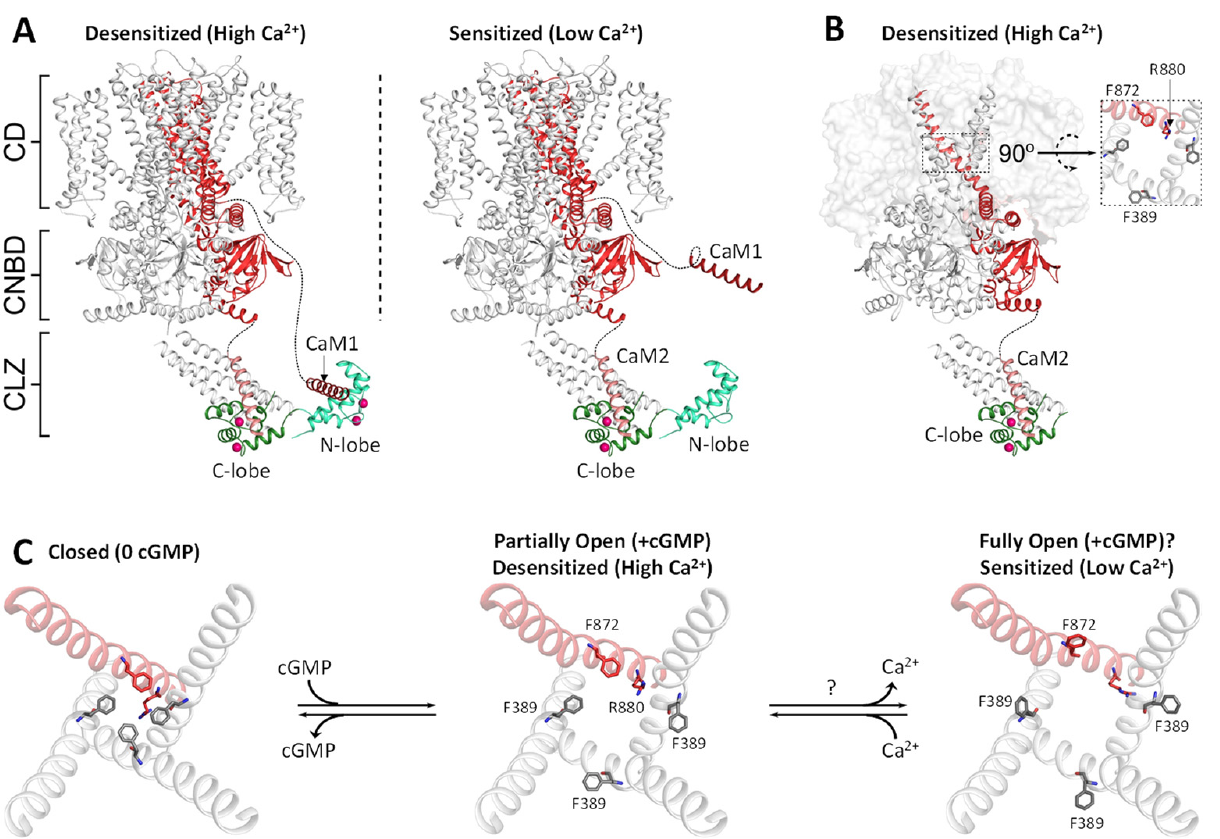
Figure 4. Two structural models of CNG channel regulation controlled by CaM. ( A ) Two-site model proposes that CaM binds to two separate sites (CaM1 and CaM2). Adapted from [53]. CNGB1 is highlighted in red. Bound Ca 2+ are magenta spheres. The CNG channel at low Ca 2+ concentration in light-activated photoreceptors has the Ca 2+ -bound CaM C-lobe (dark green) bound to CaM2 (light red) and Ca 2+ -free CaM N-lobe (light green) does not bind to the channel (right panel). The CNG channel at high Ca 2+ concentration in the dark-adapted photoreceptor has the Ca 2+ -bound CaM C-lobe and N-lobe bound to CaM2 and CaM1, respectively (left panel). ( B ) A one-site model proposes that CaM binds functionally to only one site (CaM2). At high Ca 2+ levels, the Ca 2+ -bound CaM C-lobe binds to CaM2 and is proposed to stabilize the structure of the S6 helix that causes CNGB1 residues (F872, I876 and R880) to point inward to block the channel pore in the desensitized state (see inset). At low Ca 2+ levels, the Ca 2+ -free CaM dissociates from CaM2, which could allow for the channel to switch to a proposed fully open state, as seen in the homomeric CNGA1 [59]. ( C ) Proposed model for Ca 2+ -dependent gating of the rod CNG channel. The closed apo state (in the light-activated photoreceptor) has CNGB1 gate residues (L872, I876 and R880) and CNGA1 residues (F389 and V393), each pointing inward to block the ion conduction pathway (left panel). The binding of cGMP causes the formation of a partially open channel (middle panel) in which CNGB1 gate residues are pointing inward to partially block the ion conduction pathway, while CNGA2 residues (F389 and V393) are pointing outward. We propose that the partial open state (middle panel) may represent the desensitized channel state in dark-adapted photoreceptors (high Ca 2+ and cGMP). A hypothetical fully open channel (right panel) is proposed to exist at low Ca 2+ levels, in which the CNGB1 gate residues are pointing outward to fully unblock the ion conduction pathway. A similar fully open state was observed for the homomeric CNGA1 channel [59] that has each CNGA1 gate residues pointing outward to fully unblock the ion conduction